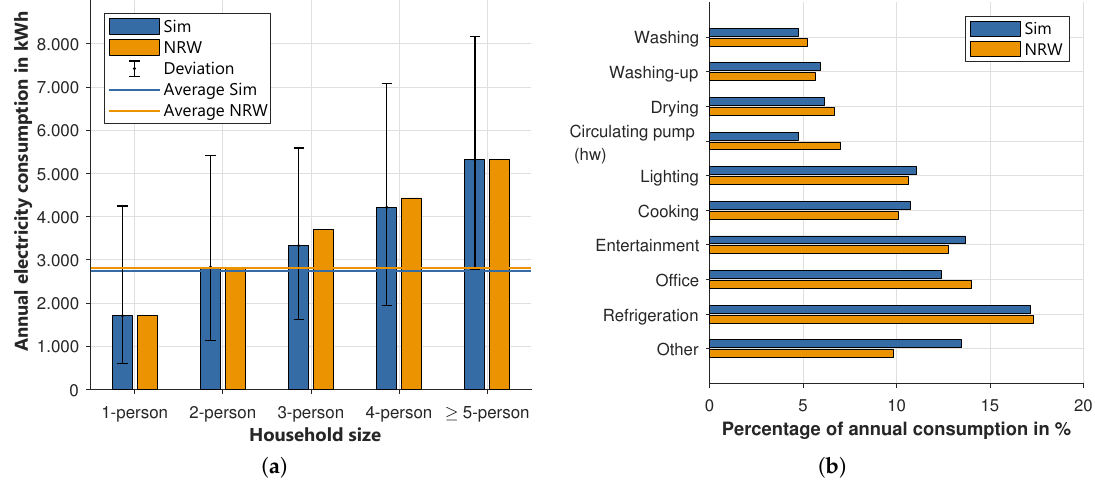
Figure 9. Distribution of electricity consumption: ( a ) annual electricity consumption depending on household size, ( b ) percentage of device